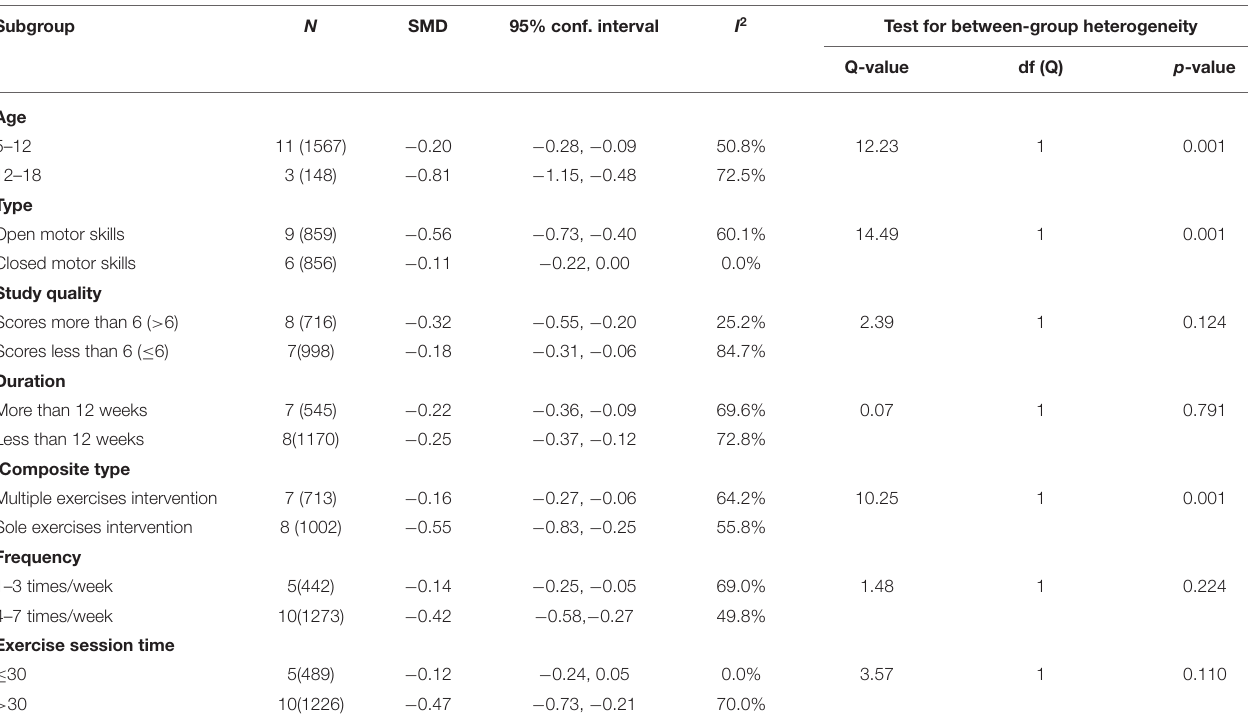
TABLE 5 | Subgroup analysis of inhibitory control (chronic exercises). SMD: standardized mean difference.